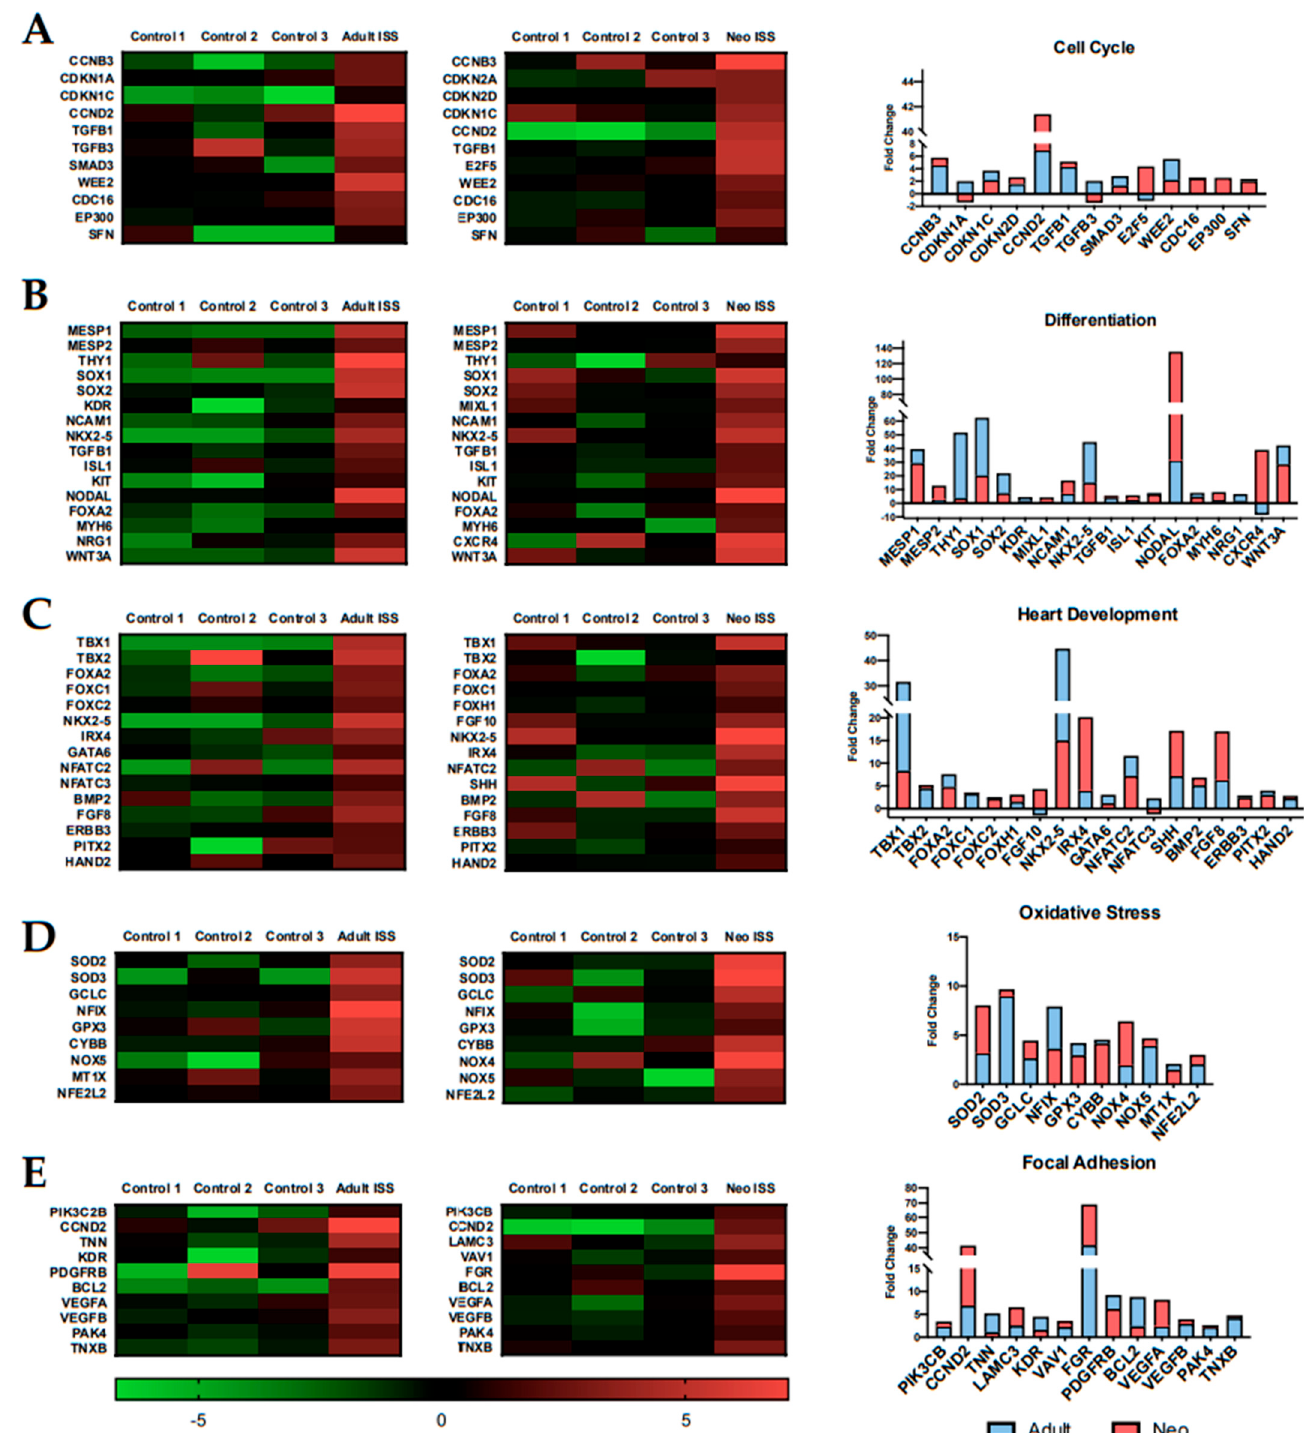
Figure 5. Gene transcripts associated with repair mechanisms were induced in flown CPCs compared to ground controls. Reparative processes that were induced by spaceflight include ( A ) cell cycle, ( B ) differentiation, ( C ) heart development, ( D ) oxidative stress, and ( E ) focal adhesion.